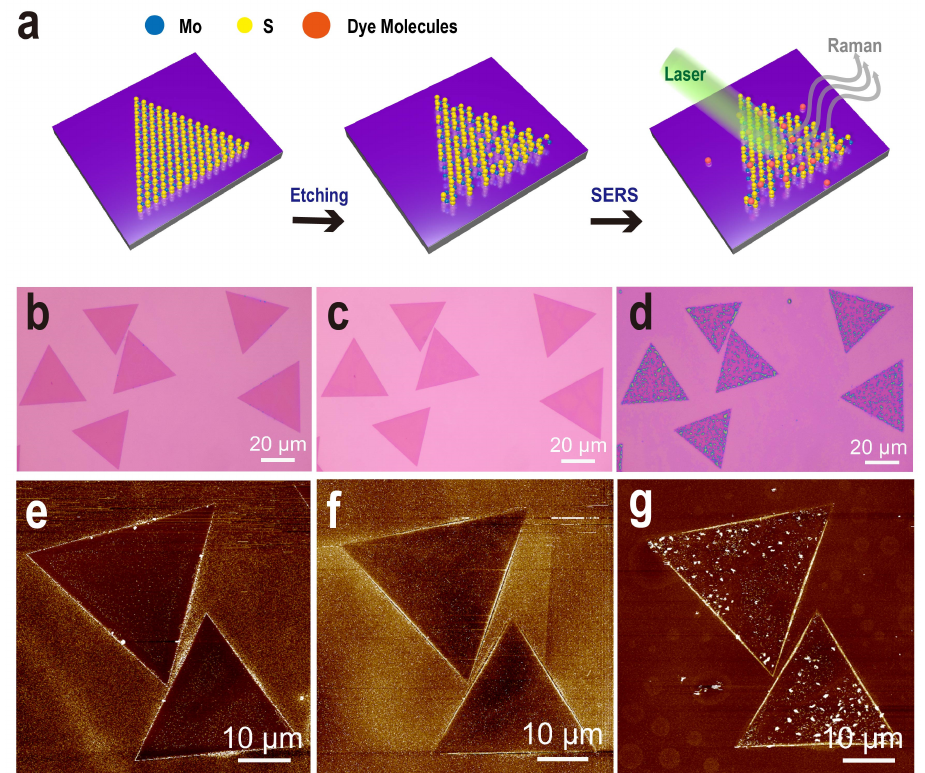
Figure 1. ( a ) Simple schematic illustrating the process of SERS detection after etching monolayer MoS 2 grown on the same SiO 2 /Si substrate. Optical microscopy image ( b – d ) and AFM image ( e – g ) of the monolayer MoS 2 , the etched monolayer MoS 2, and the etched monolayer MoS 2 with dye molecules added dropwise.